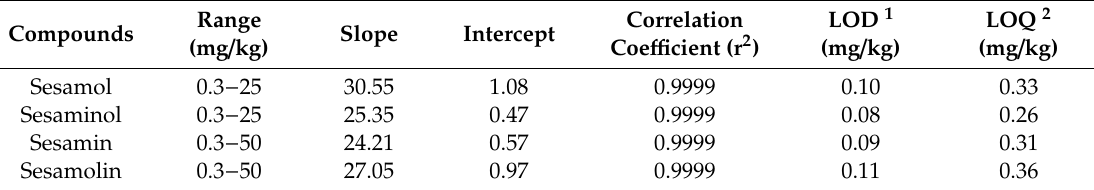
Table 1. Calibration parameters obtained for individual lignans.